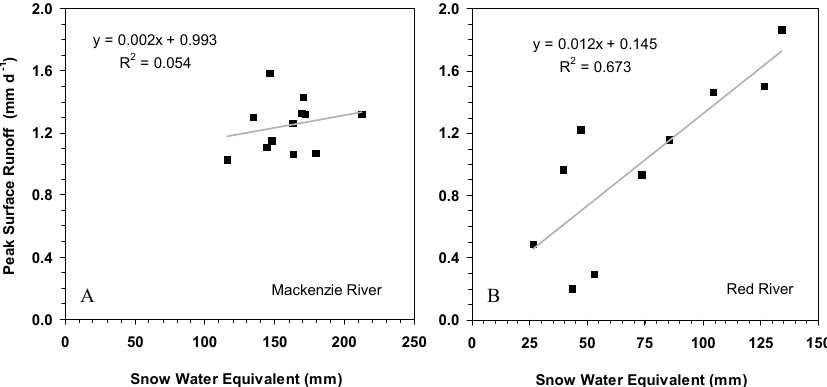
Figure 6. Comparison of the Mackenzie River Basin ( A ) vs. the Red River Basin ( B ) for the relationships between peak surface runoff ( Q runoff ) and snow water equivalent at spring break-up ( S b ).